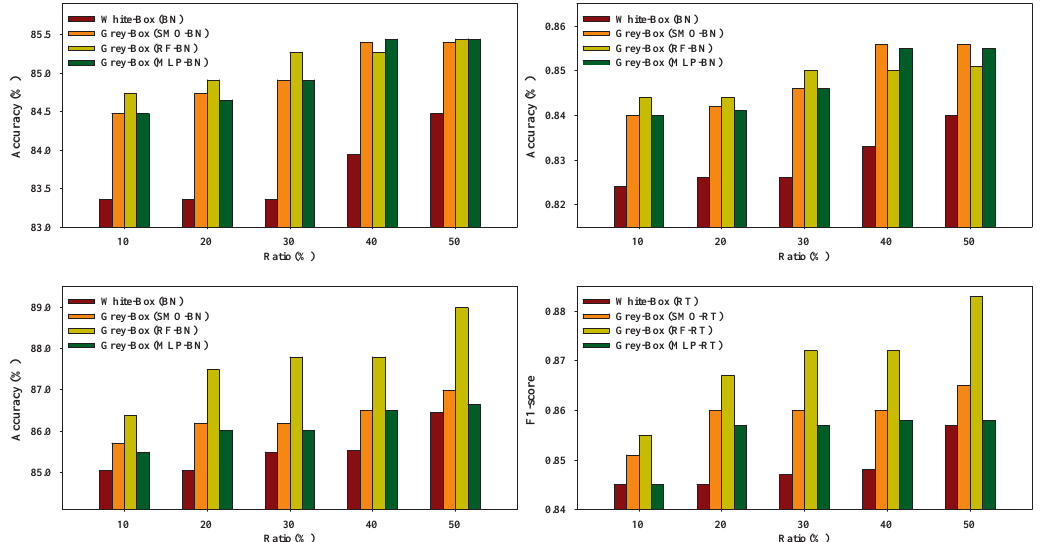
Figure 3. Box-plot with performance evaluation of Grey-Box and White-Box models for EduDataA